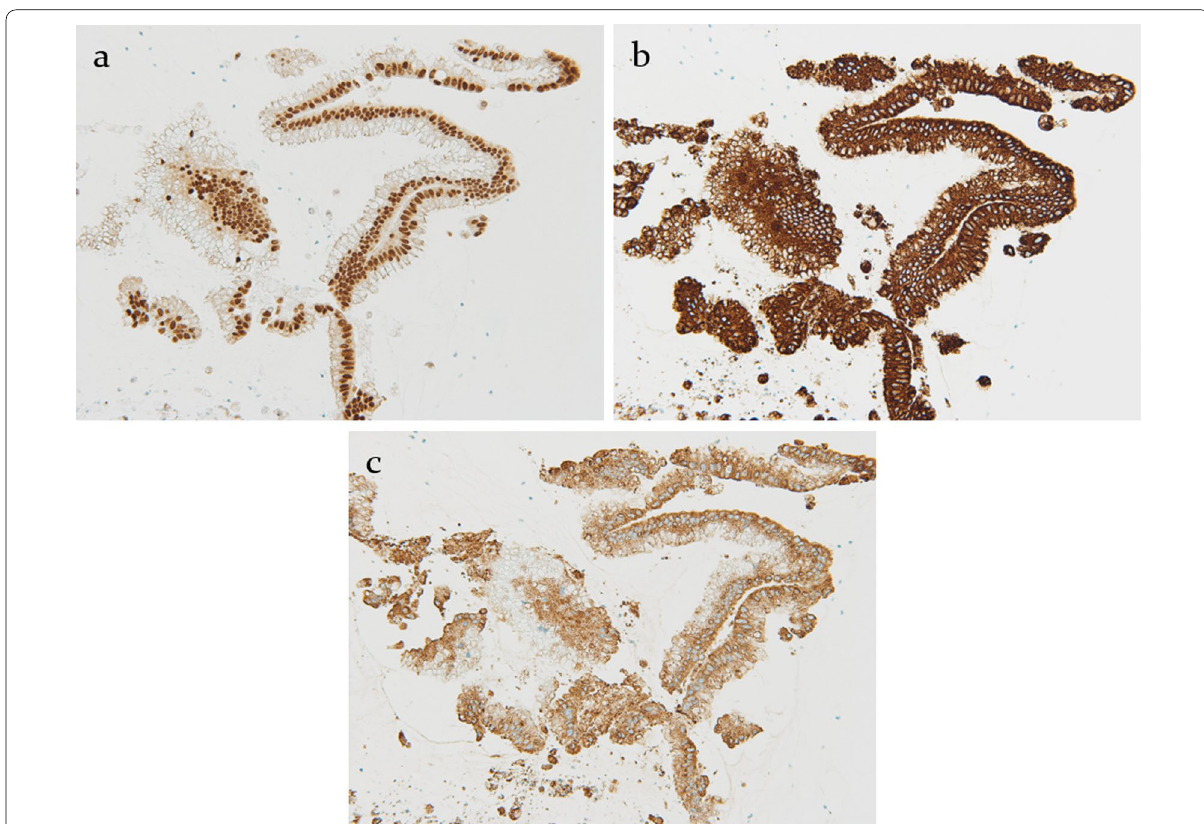
Fig. 5 a – c Cancer cells exhibited strong expression of “intestinal” differentiation markers, including CDX2, ( c